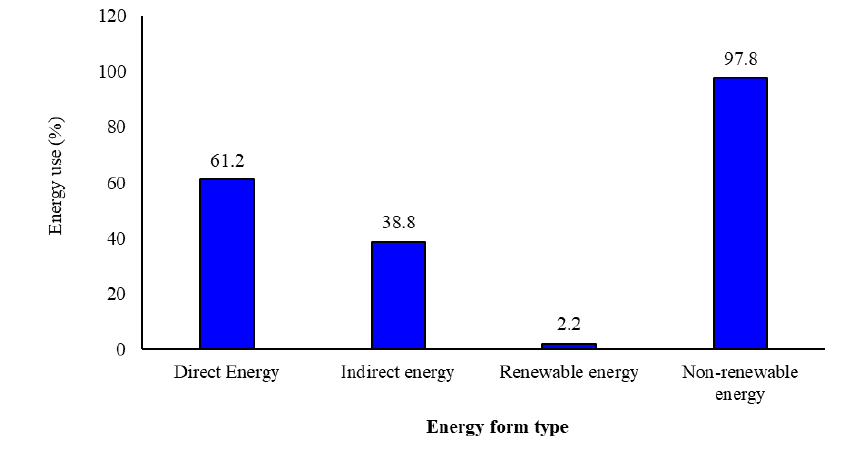
Fig. 2. Distribution of energy forms in sunflower